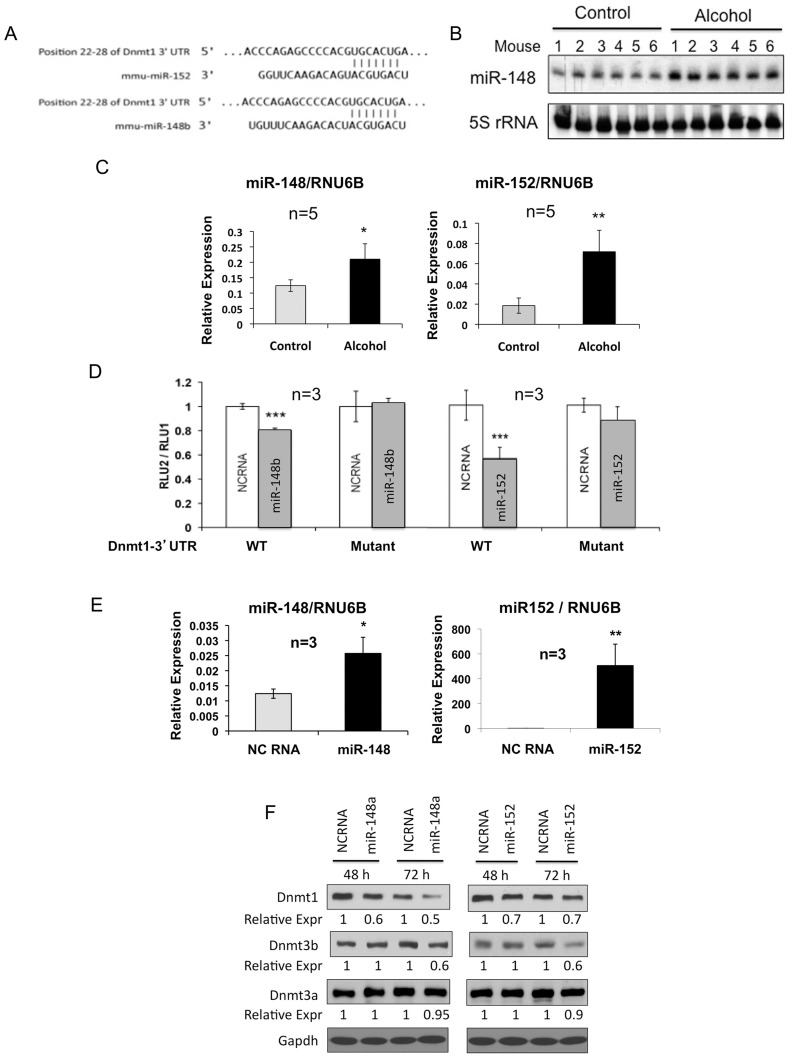
miR-148 and miR-152, which target Dnmt1 and Dnmt3b, are upregulated in the livers of the wild type mice fed the liquid alcohol diet.
A. miR-148/152 cognate site predicted by TargetScan in the 3′-UTR of Dnmt1. B. Northern blot analysis demonstrated increased expression of miR-148 in mice fed alcohol. Total RNA (5 µg) was separated in 15% acrylamide-8 M urea gel, transferred to nylon membrane and subjected to Northern blotting using 32P-labeted anti-miR-148 oligo as probe, washed and subjected to autoradiography. The blot was rehybridized to 5S rRNA probe after stripping to demonstrate comparable RNA in each lane. C. qRT-PCR analysis confirmed upregulation of hepatic miR-148&152 in mice fed alcohol. miR-148/152 and RNU6B were measured in the liver cDNAs using Taqman probes and primers specific for each miRs and the data was normalized to RNU6B level. D. Dnmt1 is a validated target of miR-148&152. Hepa cells were transfected with psiCHECK2 vector harboring wild type or mutant Dnmt1 3′-UTR downstream of renilla luciferase coding region along with 50 nM miR-148b/152 mimic or scrambled RNA (NC RNA). After 48 h, renilla (RLU2) and firefly luciferase (RLU1) (expressed from the same vector) activities were measured and the data are represented as RLU2/RLU1. Each assay was performed in triplicate. E. Upregulation of miR-148/152 in Hepa cells transfected with the respective miRs compared to the controls (NC RNA transfected cells). Total RNAs from each sample in D was subjected to qRT-PCR as described in B. Each assay was performed in triplicate. F. Endogenous DNMT1 and DNMT3b protein levels were reduced in cells expressing ectopic miR-148/152. H293T cells were transfected with 50 nM miRs or NC RNA. After 24 h, cells were split and harvested at indicated time points post-transfection for western blot analysis of whole cell extracts (100 µg) with specific antibodies. Relative expression was determined after normalization of the signal to that of Gapdh. Single, double and triple asterisks represent P-values ≤0.05, ≤0.01 and ≤0.005, respectively.